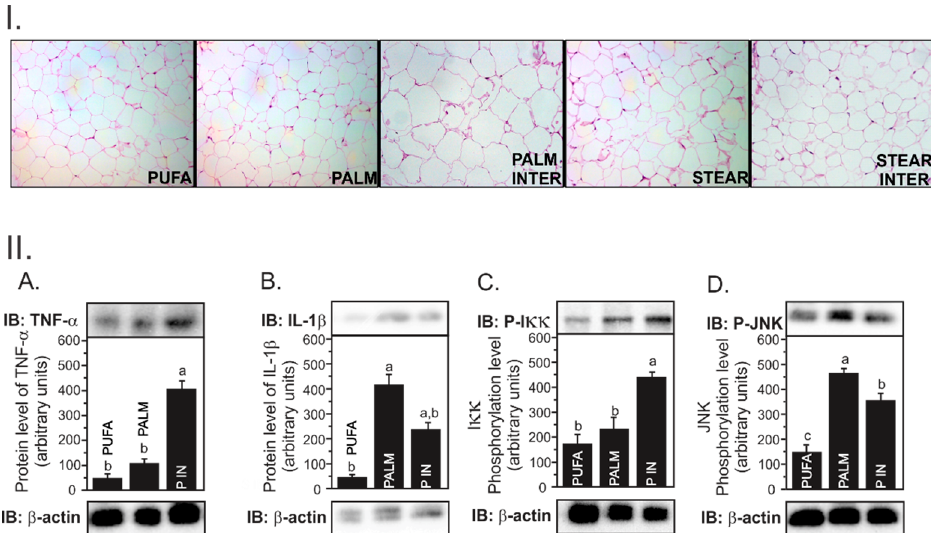
Figure 1. PALM INTER group promotes adipocytes hypertrophy ( I ) and induces inflammatory cytokine expression ( A , C ). ( I ). Photomicrography of epididymal visceral adipose tissue dissected from LDLr-KO mice fed a high-fat diet enriched with polyunsaturated fatty acids (PUFA), palmitic acid (PALM), palmitic interesterified fat (PALM INTER), stearic acid (STEAR), and stearic interesterified fat (STEAR INTER) for 16 weeks. Sections were stained with hematoxylin eosin and photomicrography is presented under 20x objective lens. ( II ). Western blot analysis from Both stearic groups (STEAR and STEAR INTER groups) was not performed ( A – D ) because of the small amount of adipose tissue obtained in these groups. Data were checked for normality prior to statistical analysis. One-way ANOVA was performed, followed by the post hoc Newman–Keuls test. Statistically significant difference is presented by different letters ( p < 0.05) with a > b > c values. Data are shown as mean ± SEM ( n = 6). Table 2. Initial weight, food intake, body weight gain, relative weight of adipose tissue, adipocyte area of LDLr-KO mice fed experimental diets for 16 weeks.